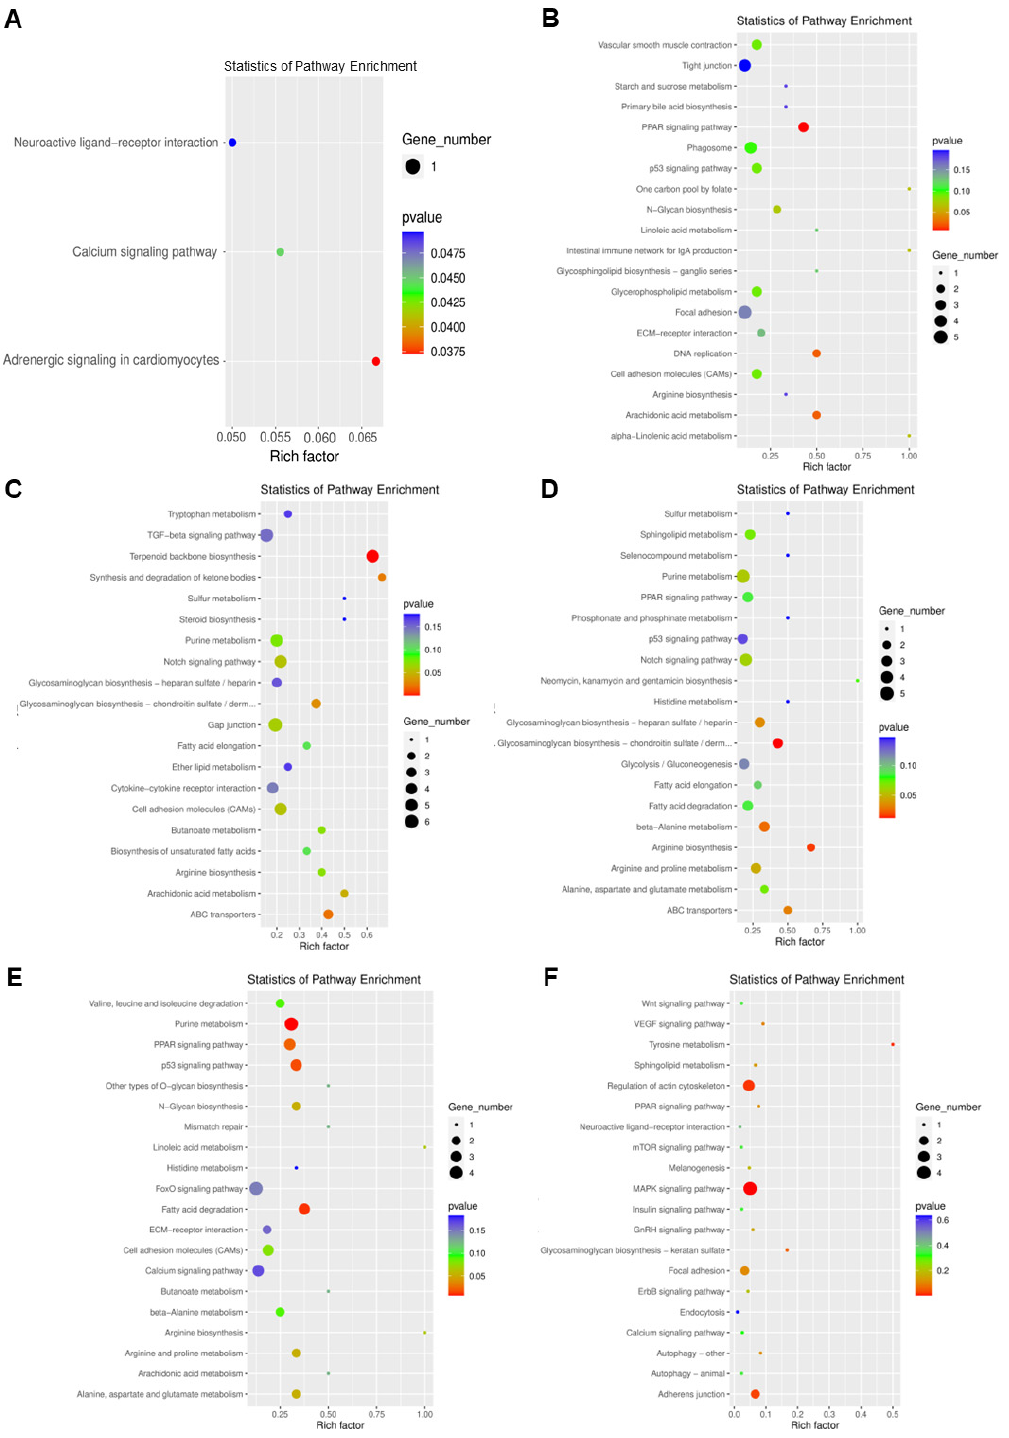
Figure 6. KEGG enrichment analysis of genes with significant differences in methylation and tran- scription levels in each comparison group. ( A ) is the comparison group of SP and Control. ( B ) is the comparison group of BBR and Control. ( C ) is the comparison group of SP + BBR and Control. ( D ) is the comparison group of SP + BBR and SP. ( E ) is the comparison group of BBR and SP. ( F ) is the comparison group of SP + BBR and BBR comparison